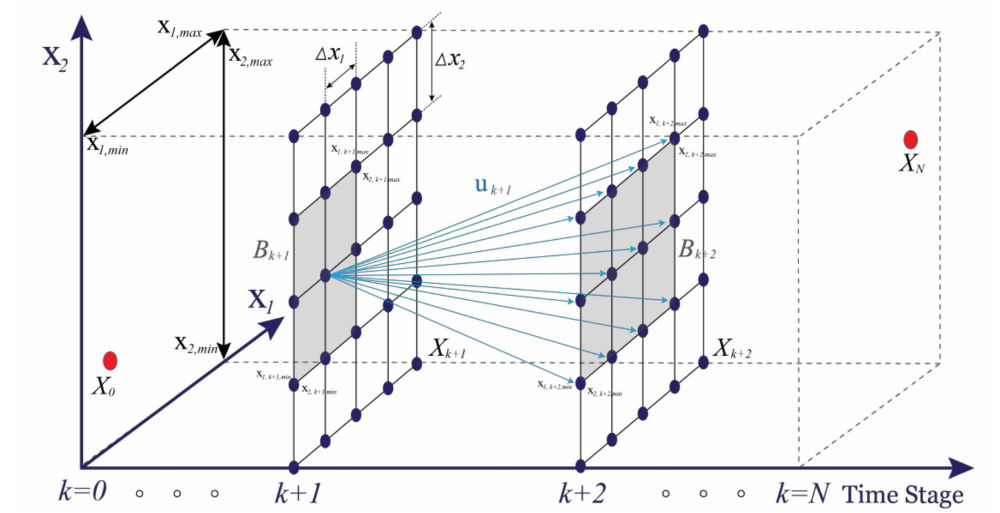
Figure 2. Stagewise optimization procedure of the modified dynamic programming approach. The dark blue dotted points in Figure 2 are all the grid points in the full state space. The highlighted grey area in each stage is the block of grid points in that stage, which is defined by the state space that is reachable from the admissible states of the previous stage. Only the grid points inside this highlighted grey area are considered for the MDP optimization process. This reduction in search space in the optimization procedure reduces the computational space and time complexity. Figure 2 also illustrates the control